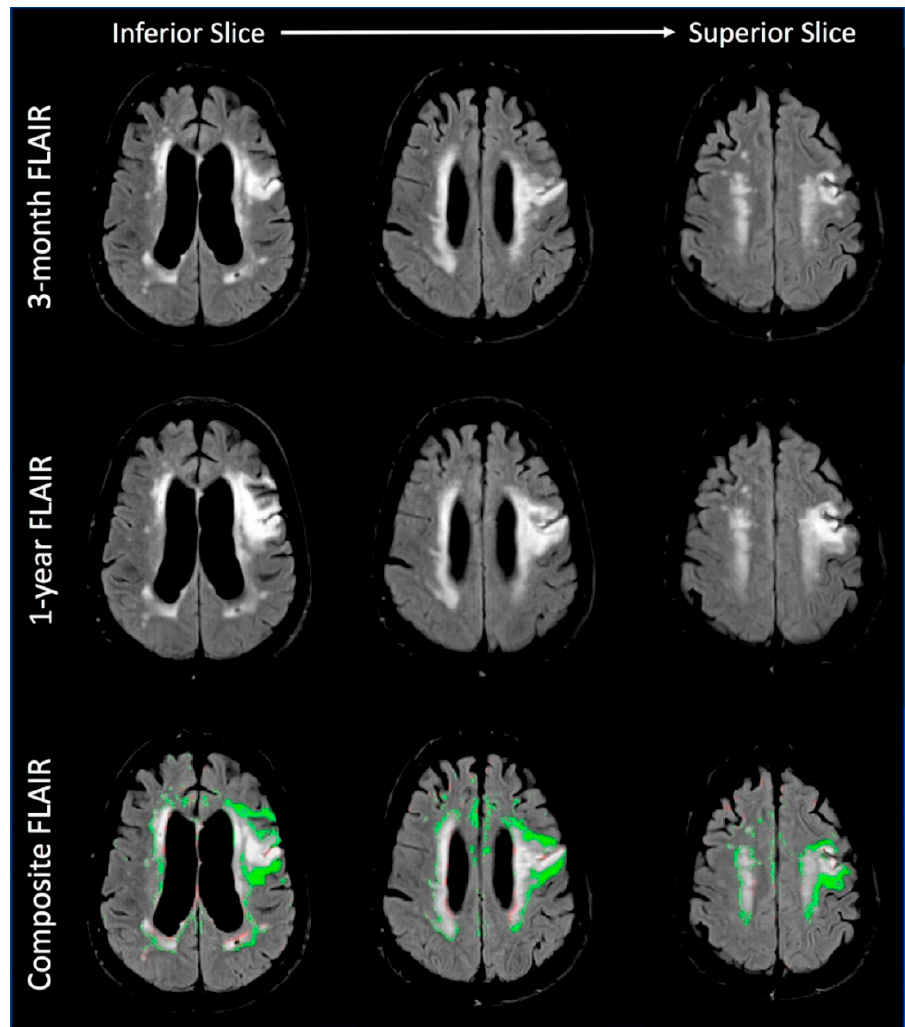
Figure 4. The increase in white matter hyperintensities (WMH) between the 3-month time point and the 1-year time point is shown for three regions in the brain. The first row is the FLAIR MRI from the 1-month time point. The second row is the FLAIR MRI from the 1-year time point. The third row is a composite image from the two time points with the increase in WMH represented in green. Red areas represent regions of decreased WMH and appear to mostly represent atrophy. The most dramatic region of WMH progression is seen in the areas immediately adjacent to the stroke